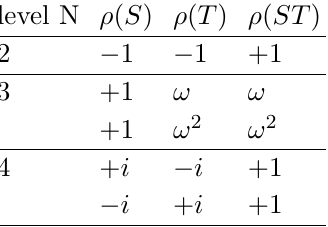
Table 7 . Independent one-dimensional representations for N = p λ , where p is a prime, λ an integer and ω = e i 2 π/ 3 . The trivial representation ( ρ ( S ) , ρ ( T )) = (+1 , +1) is common to all